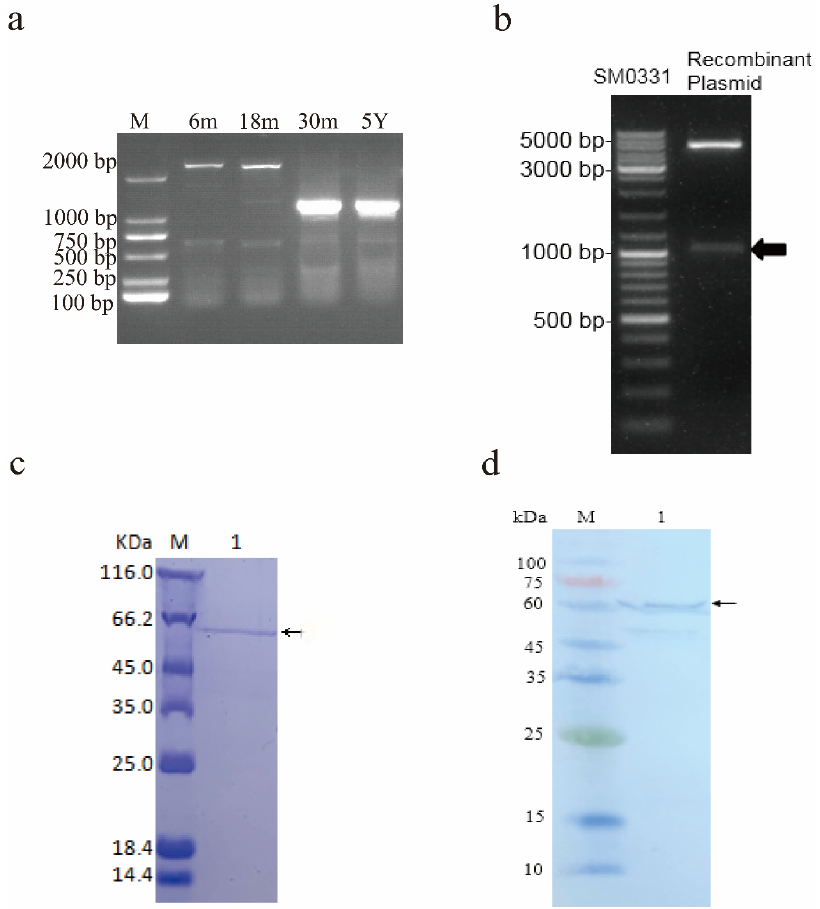
Figure 1. Identification and protein purification of the yak TSSK4 alternative spliceosomes.